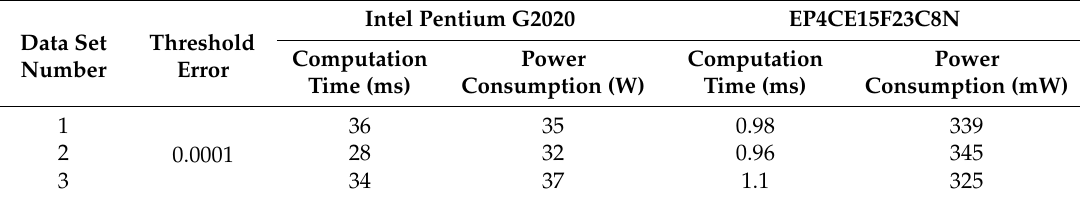
Table 5. Training time and consumption comparison of the CPU and FPGA. CPU: Central Processing Unit; FPGA: Field Programmable Gate